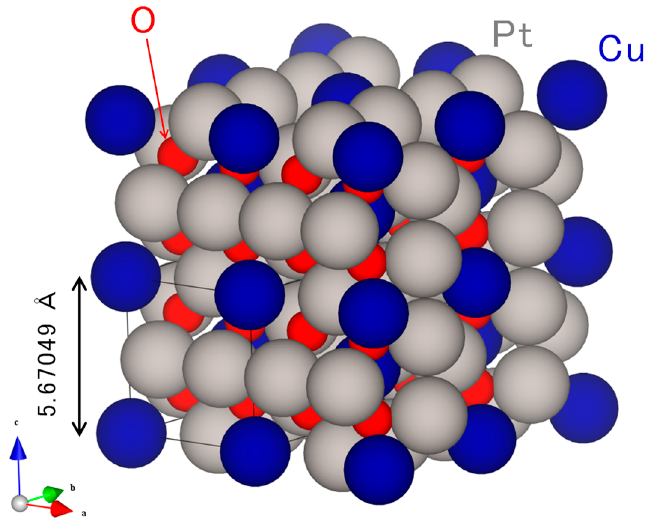
Figure 1. Crystalline structure of Co Pt bronze.